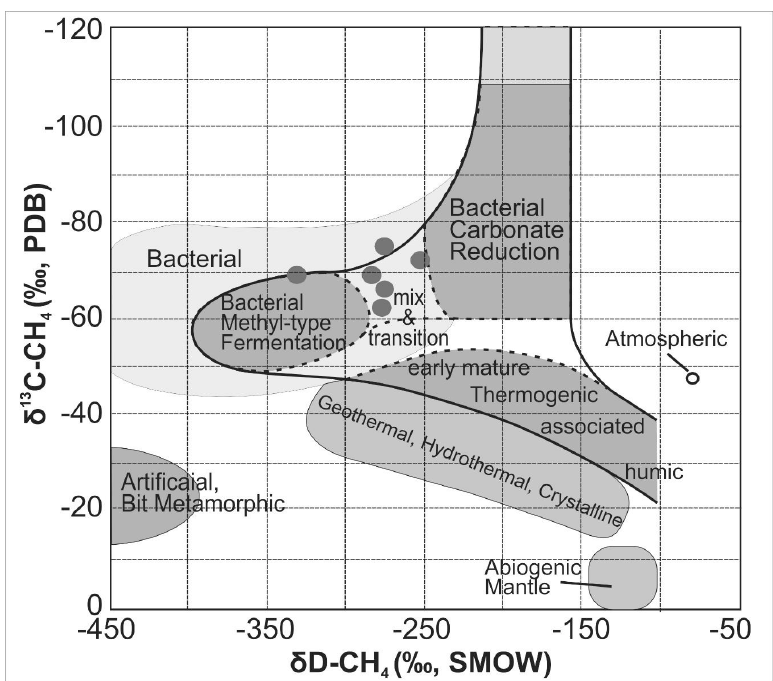
Figure 5. Methane isotope composition (black circles) of gas bubbles collected from MTGI of the natural gas, depending on the ratio of isotopes δ 13 C (methane) and D (methane).